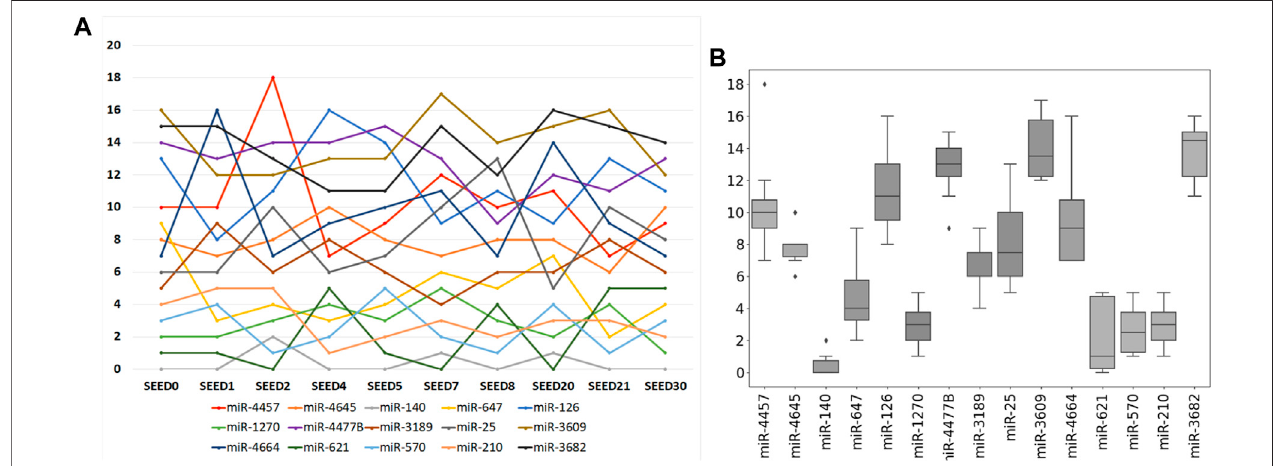
FIGURE 5 | Ranking of each selected miRNA according to ten times of the sample division. (A) Line chart of each selected miRNA. Its horizontal and vertical ordinates refer to ten times of sample split and the accumulated score orders of the selected miRNAs, respectively. (B) Corresponding box diagram of each selected